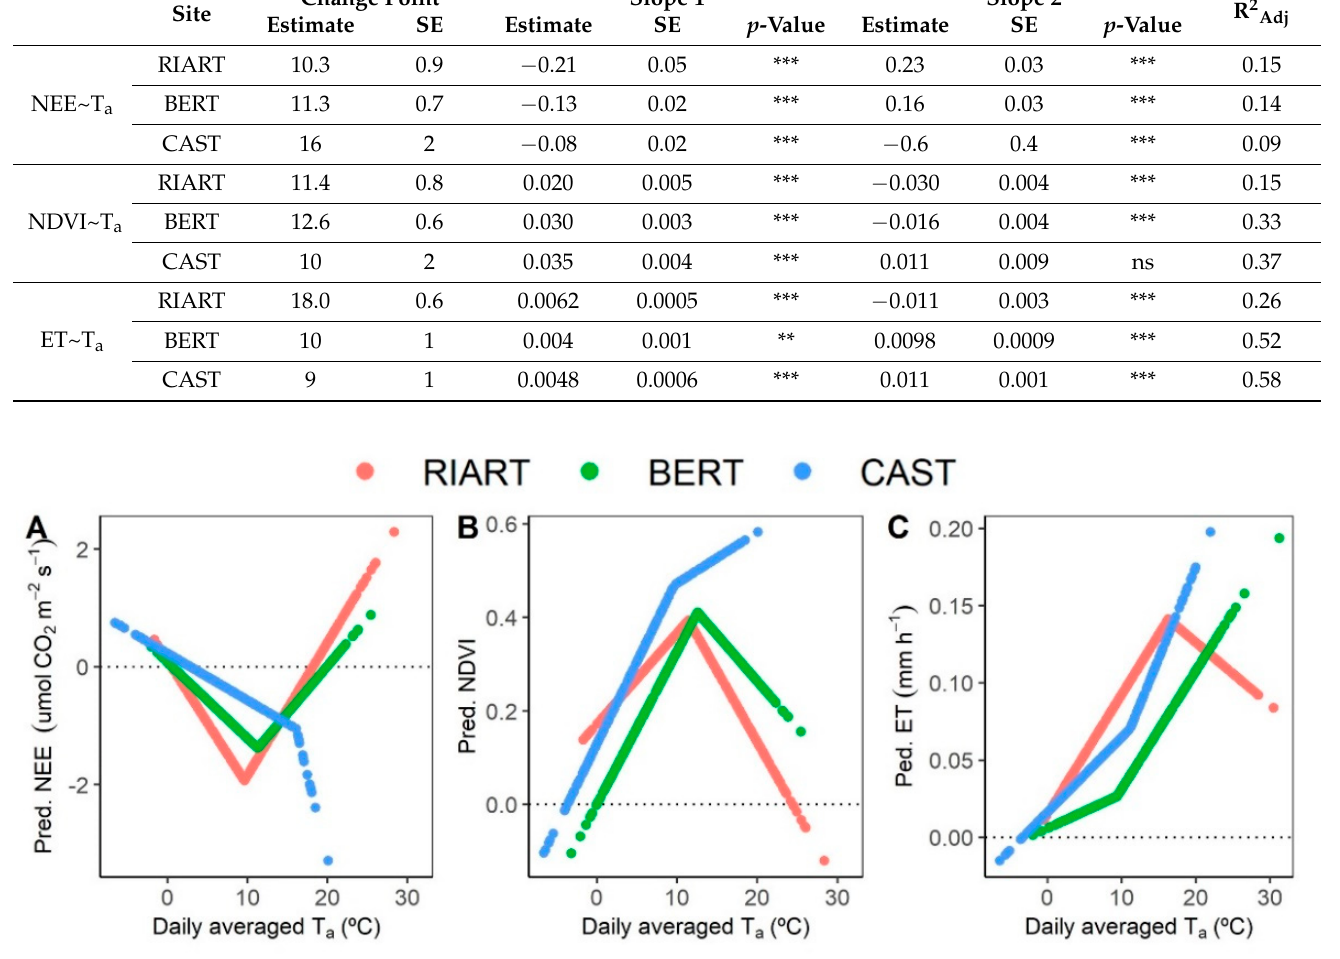
Figure 7. Predicted net ecosystem exchange (NEE), normalized vegetation index (NDVI), and evapotranspiration (ET) according to the segmented linear models of Table 2.